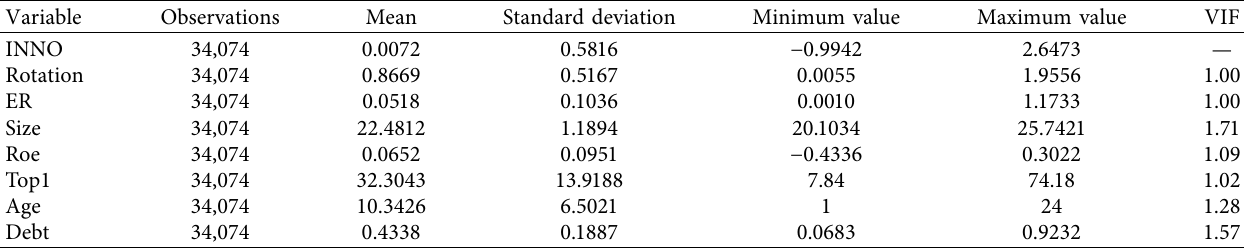
Table 6: Descriptive statistics for key